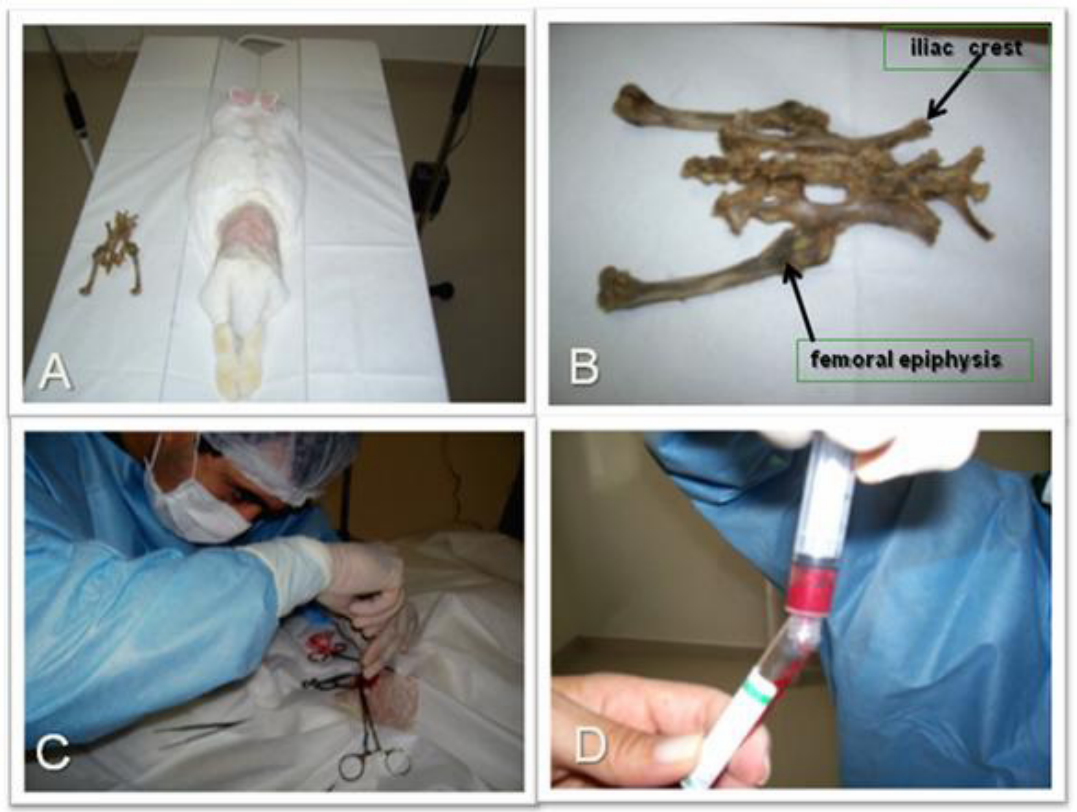
density). The mononuclear cell layer was aspirated with a pipette, washed twice for Ficoll-Hystopaque removal, and resuspended in DMEM medium (Figure